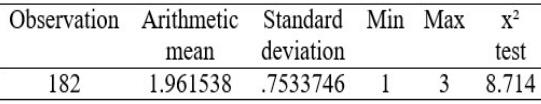
Table 4. Results of statistical analysis of